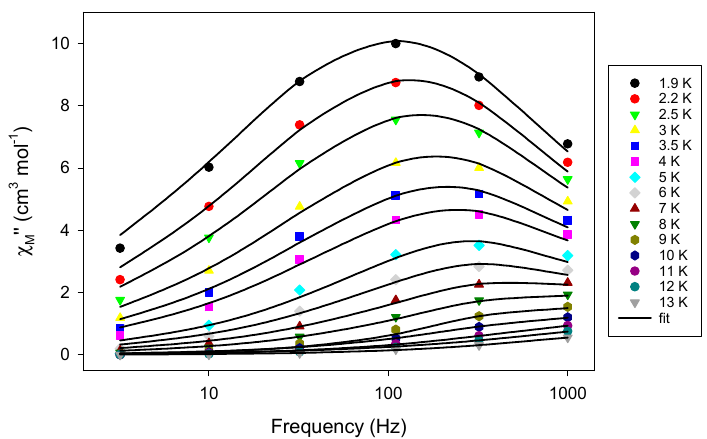
Figure 6. Frequency dependence of the in-phase ( χ Μ ′ , top ) and out-of-phase ( χ Μ ′′ , bottom ) ac magnetic susceptibilities at zero dc field for 1 · 3MeOH · CH 2 Cl 2 , measured in a 3.0 G ac field at the temperature range 1.9–13 K. Solid lines represent fits to the data, as described in the main text.